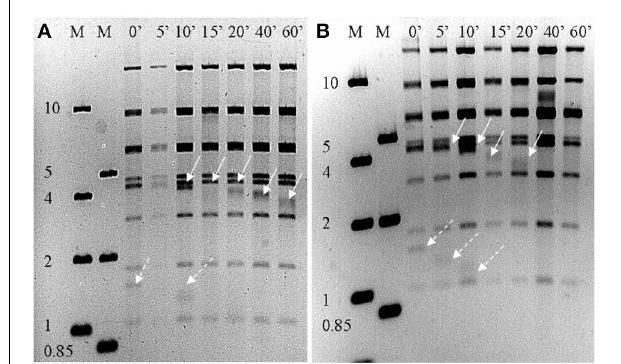
FIGURE 3 | Nde1 digested (A) RLP1 and (B) RPP1 genomic DNA after treatment with Bal31 for the indicated time intervals. Solid arrows indicate restriction fragment decreasing over time, dotted arrows indicate possible second disappearing restriction fragment. The presence of fragments reducing in size with time indicates the phage genome is linear not circular. M, DNA marker